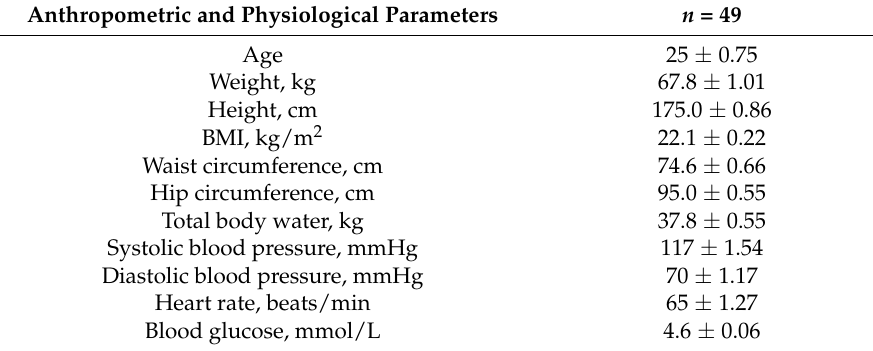
Table 1. Baseline characteristic of